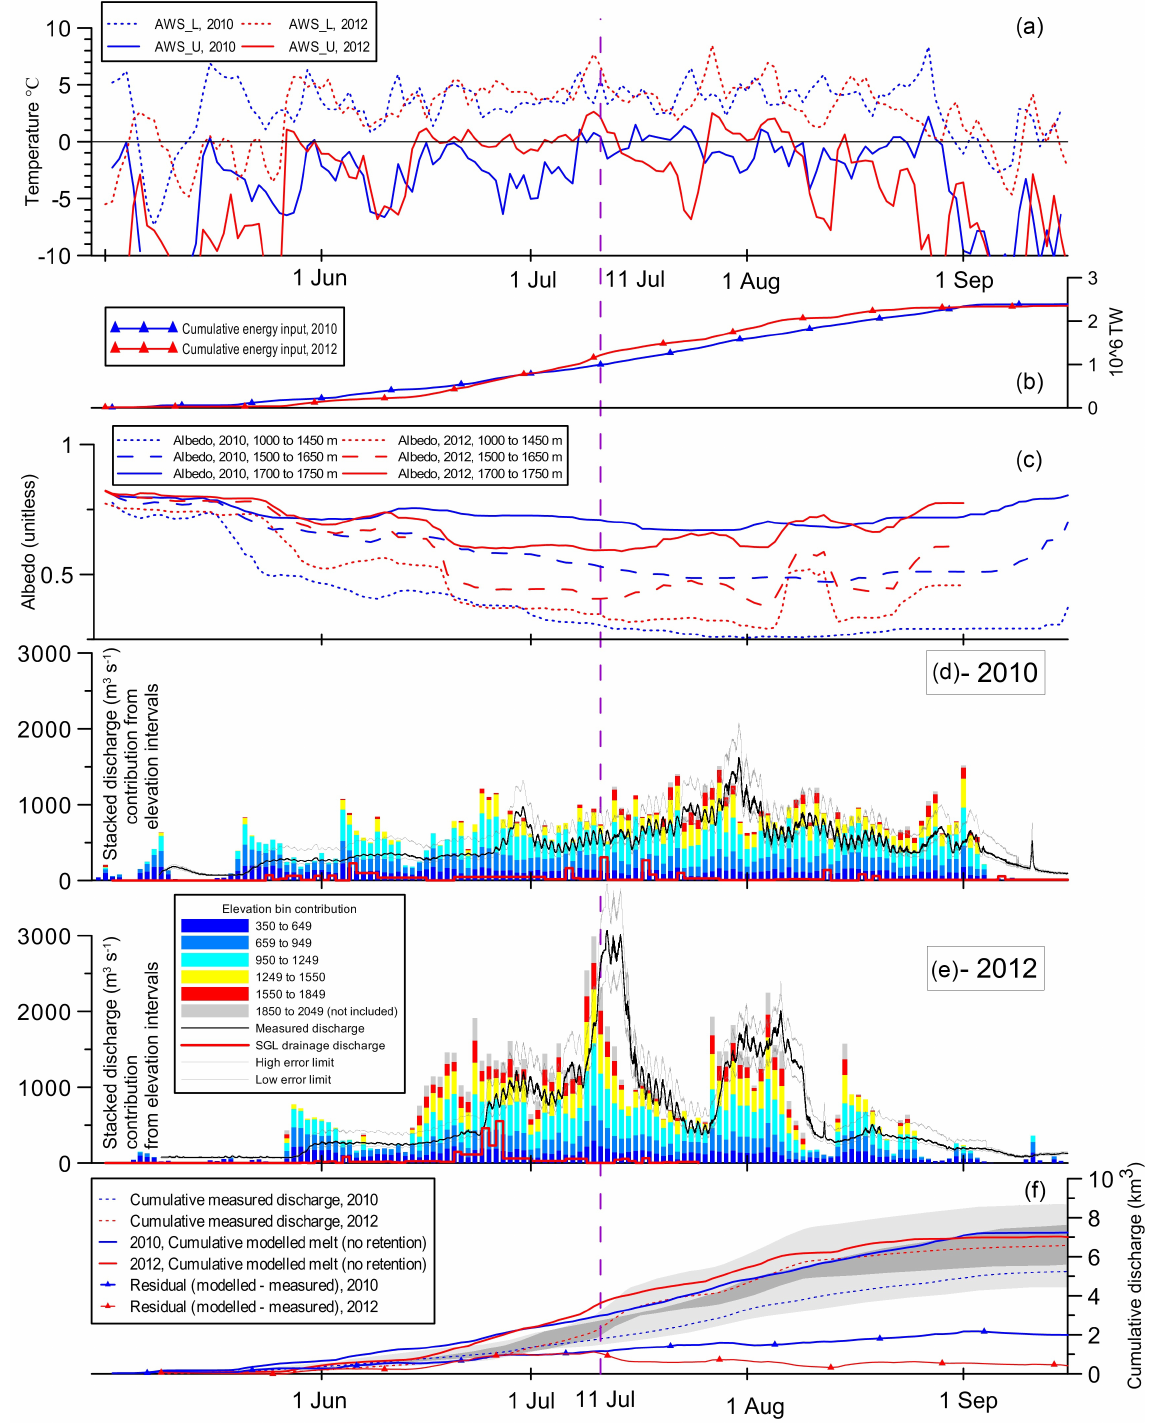
Figure 3. Meteorological records, discharge measurements and modelled melt runoff for the study area during 2010 and 2012, including (a) daily average air temperature at AWS_L and AWS_U. To avoid cluttering, temperatures below − 10 ◦ C are not shown. Likewise the air temperatures at AWS_M , which usually lies between that of AWS_ L and AWS_U, are not plotted. Panel (b) shows the calculated cumulative energy input, (c) the albedo at three different elevation bands, (d, e) the proglacial discharge, supraglacial lake drainage volume and modelled melt runoff, and (f) the cumulative proglacial discharge, modelled melt runoff and residual between the two. The dashed vertical purple line demarks the bridge washout on 11 July 2012. The uncertainty in discharge estimates is shown using grey lines on (d) and (e) and by grey shading on (f) . Where the uncertainty estimates for 2010 and 2012 overlap on (f) , a darker shade of grey is used. www.the-cryosphere.net/10/1147/2016/ The Cryosphere, 10, 1147–1159,